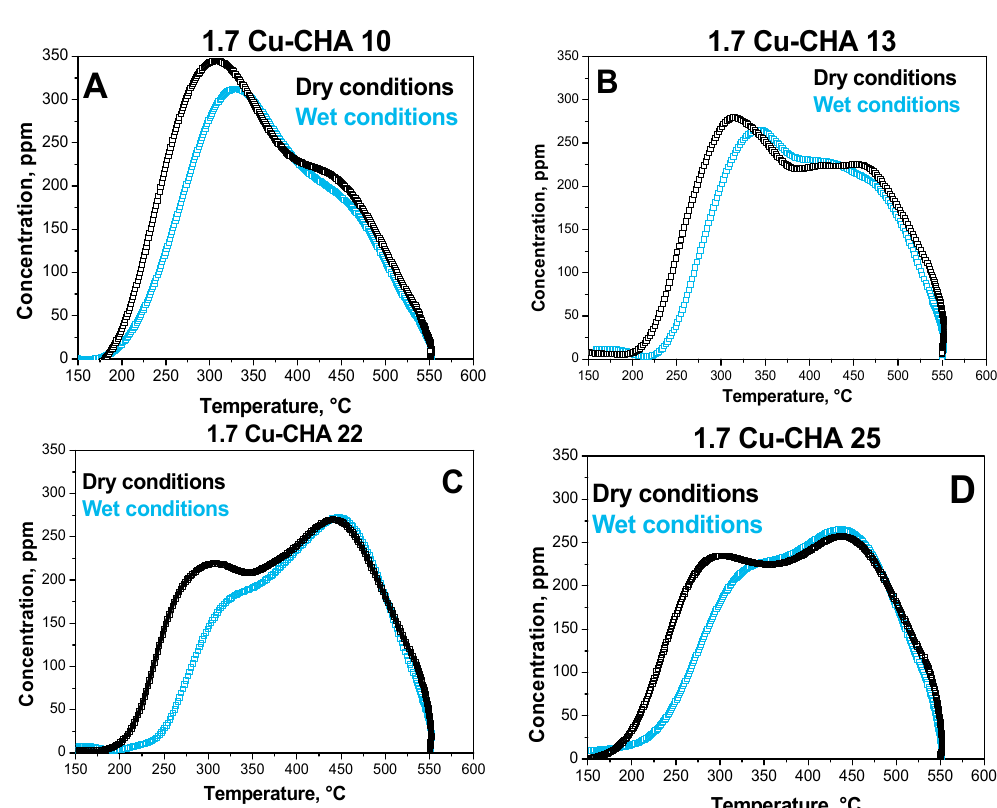
Figure 4. Comparison between dry and wet NH 3 -TPD (NH 3 + 2N 2 ) after adsorption at 150 ◦ C on Cu-CHA catalysts with Cu loading = 1.7% w / w and different SAR: ( A ) 10; ( B ) 13; ( C ) 22; ( D ) 25. NH 3 = 500 ppm, H 2 O = 0–5% v / v ; heating rate = 15 ◦ C/min, He. GHSV = 266,250 cm 3 /(g cat *h) (STP). Pre-oxidized catalysts.